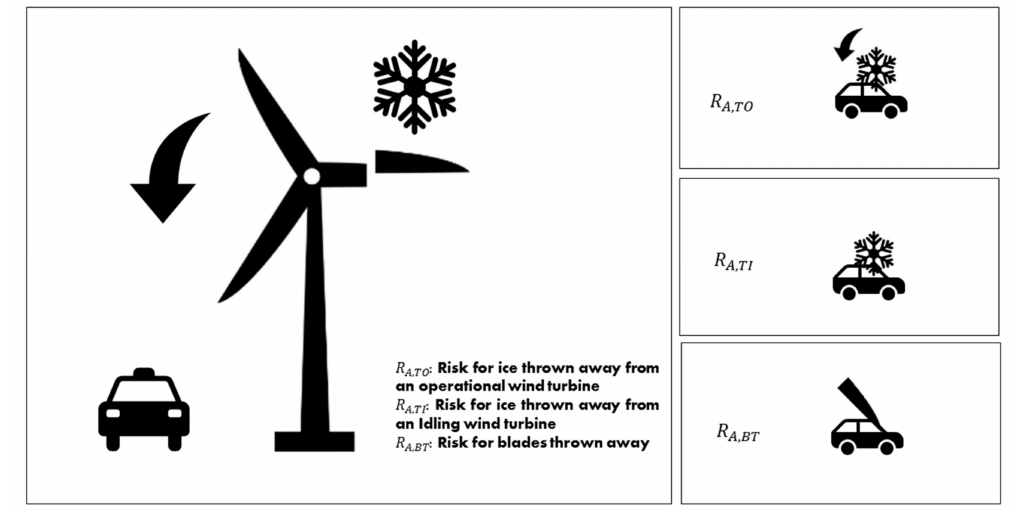
Figure 6. Illustration of risk scenarios of wind turbines close to